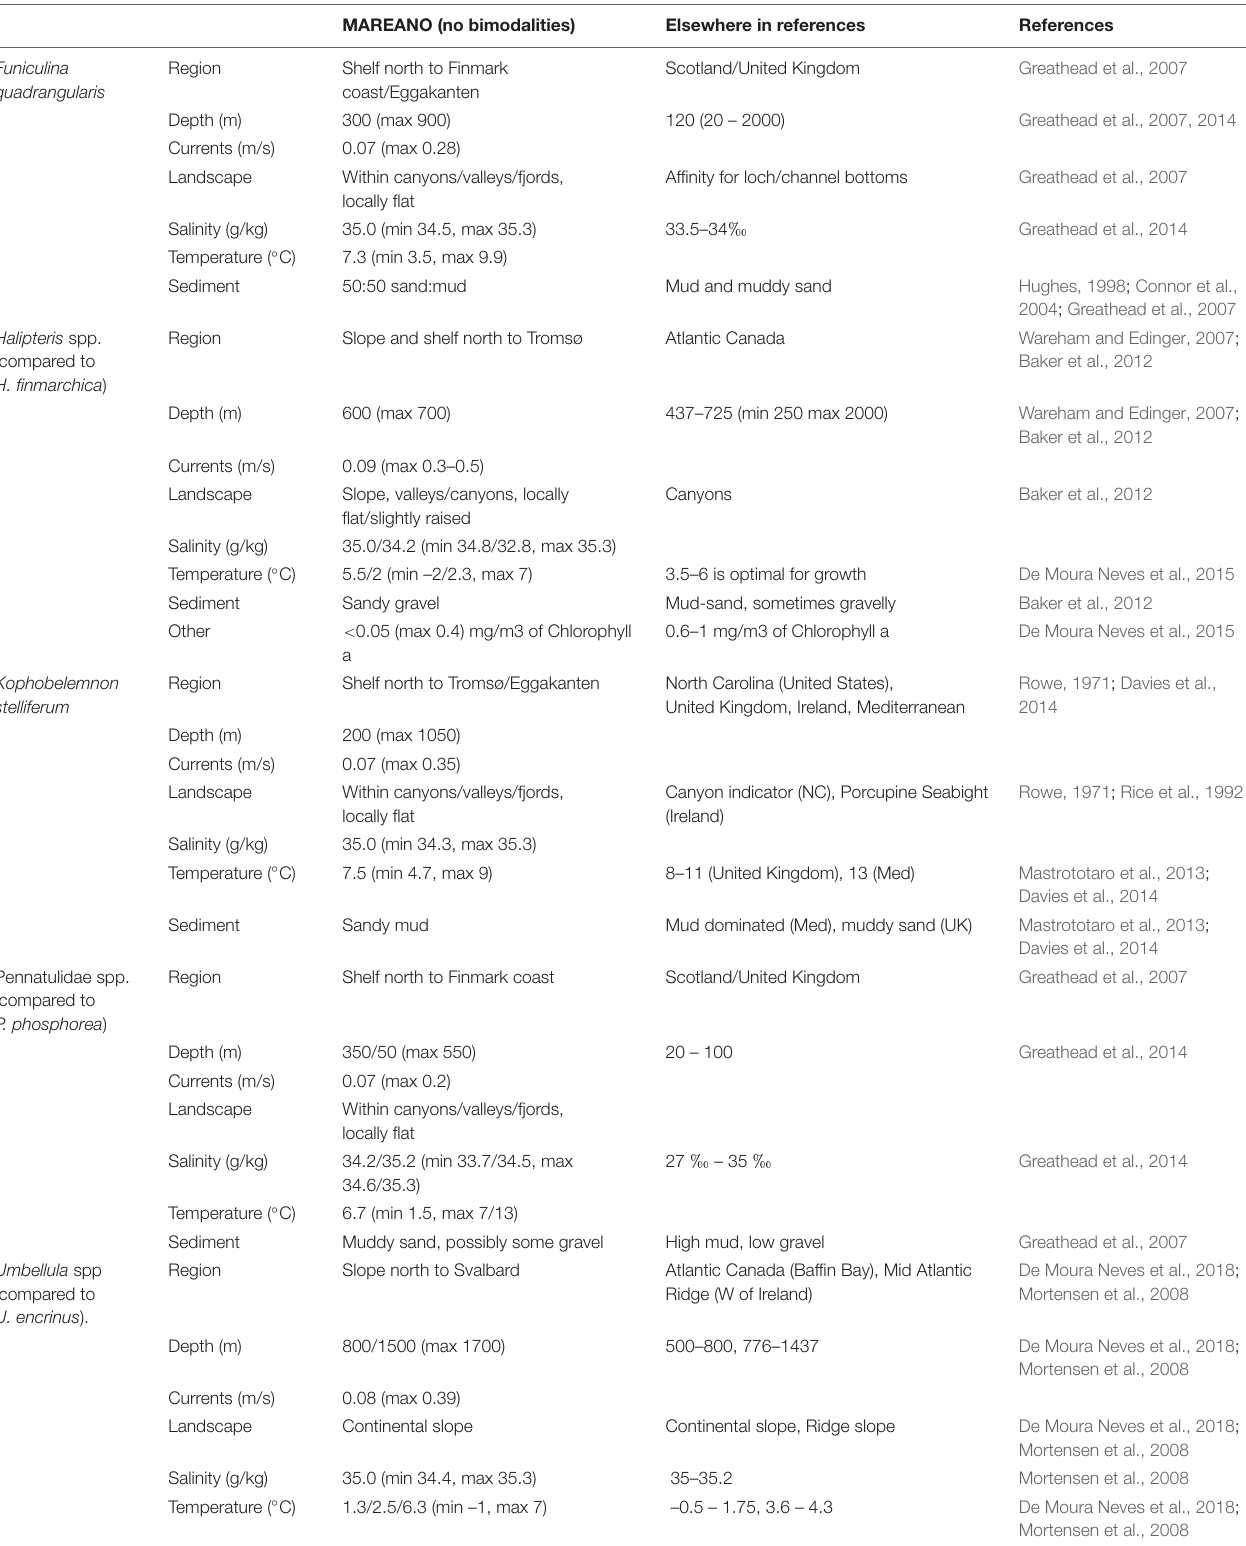
TABLE 1 | Interpreted environmental preferences for each sea pen species (or group of species) for the MAREANO data (this study, based on peaks in histograms and observed distributions), and literature comparisons from elsewhere in the world. MAREANO (no